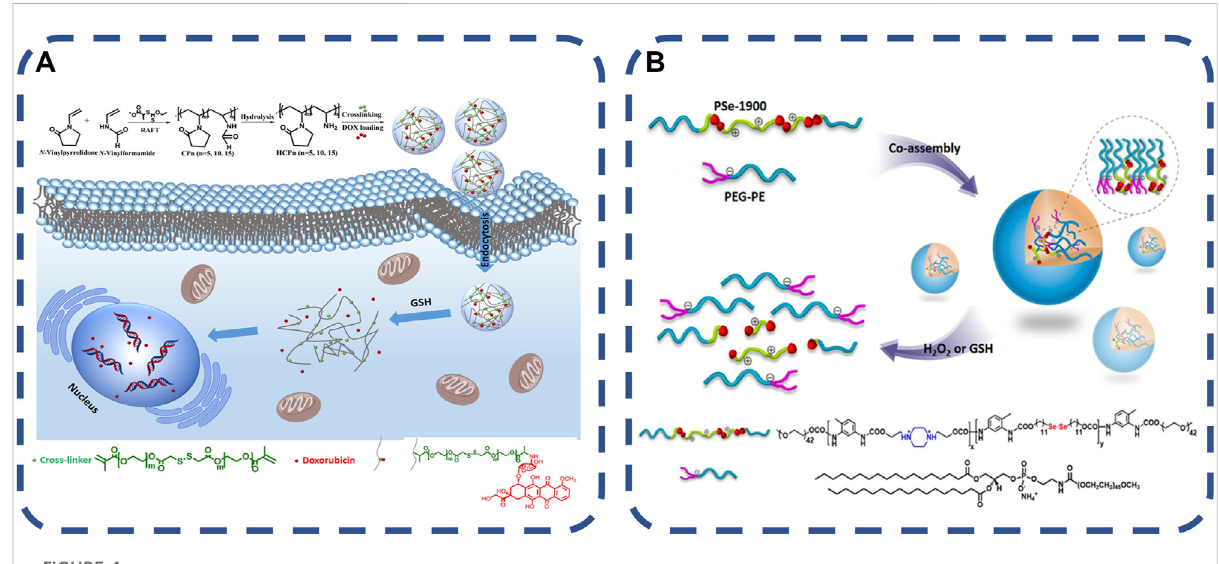
FIGURE 4 (A) redox response. The synthesis of prodrug nanogels is based on amine-functionalized polymers, which are integrated into fi ne cells in a reduced environment and trigger intracellular drug release (Peng et al., 2019).Copyright 2019, J Colloid Interface Sci. (B) Redox responsive co assemblies formed from block copolymers containing selenides and polymer lipids (Wang et al., 2014). Copyright 2014,